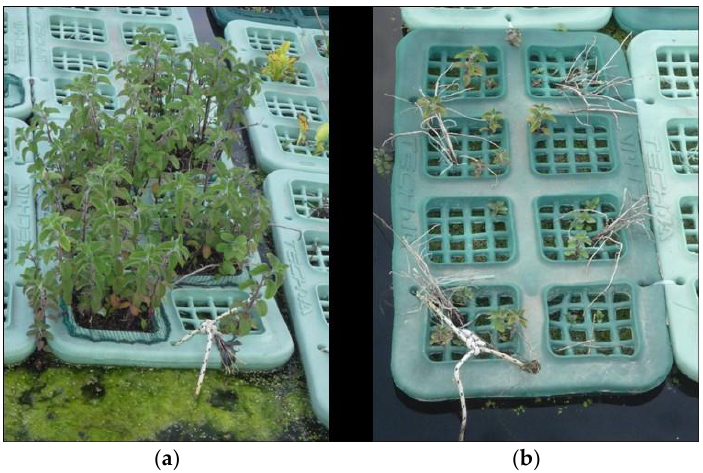
Figure 7. Different plant growth of M. aquatica with ( a ) or without ( b ) the substrate.